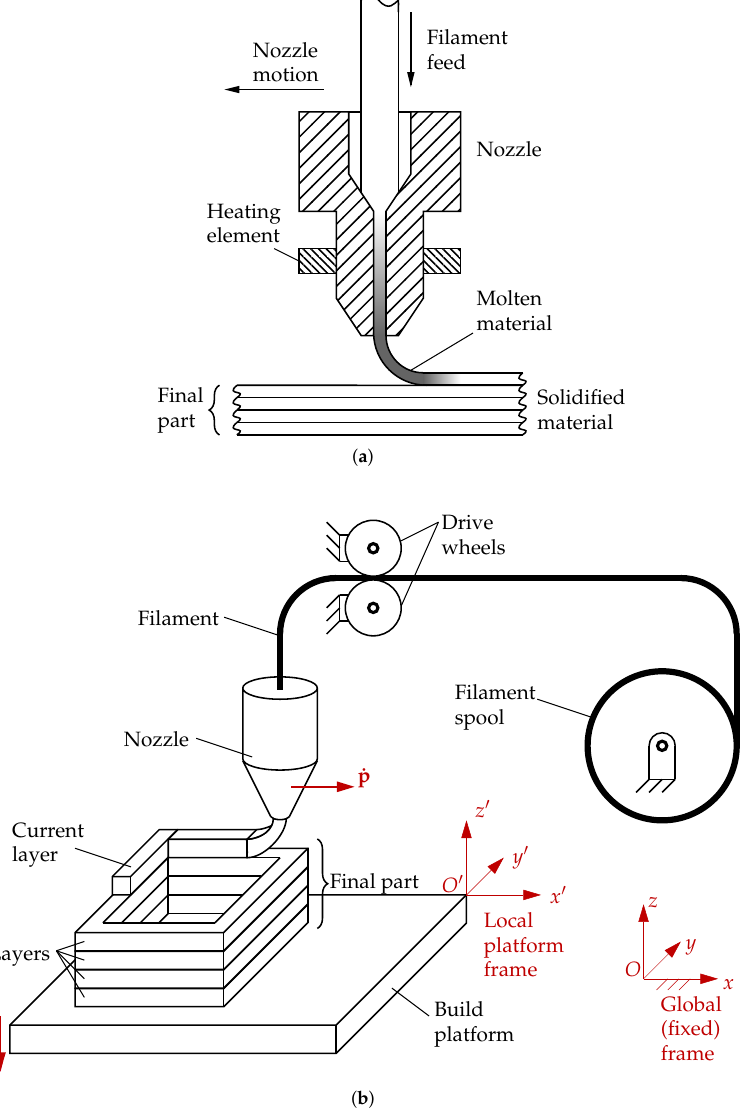
Figure 1. ( a ): Schematic of material deposition nozzle for FFF processes. ( b ): Schematic of an FFF device with Cartesian XY head architecture. The velocity ˙p of the nozzle is in the horizontal ( x – y ) plane, while the vertical motion ˙v is directly provided to the build platform on which the part is formed.